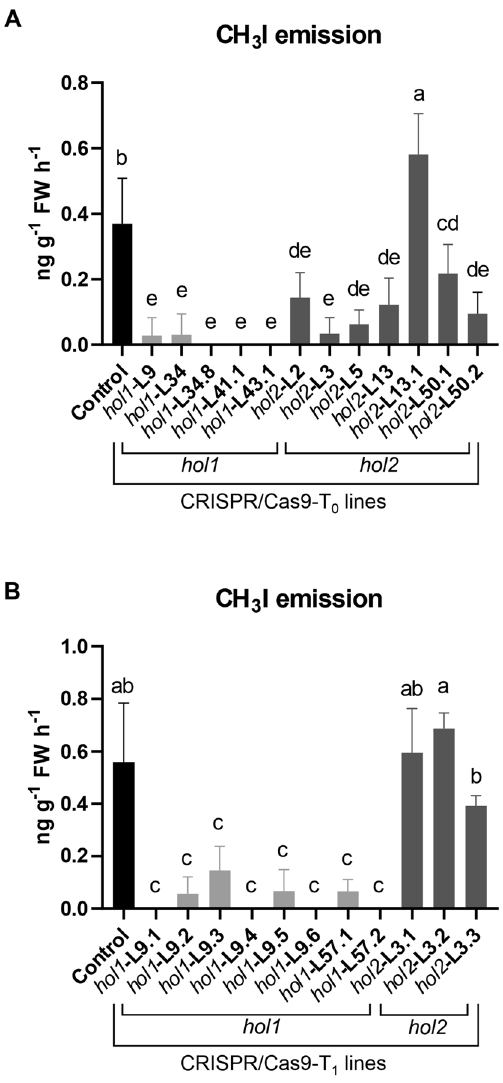
Figure 2. Methyl iodide emissions in CRISPR/Cas9 mutated lines. CH 3 I emissions were measured from T 0 ( A ) and T 1 ( B ) plants. Air samples from leaves were analyzed 24 h after incubation with 0.5 mM KI. Data points are the mean ± s.d. of four biological replicates for each line and two technical replicates per each biological sample. Data were subjected to one-way analysis of variance (ANOVA). Values followed by the same letter are not significantly different (Tukey’s HSD post-hoc test, P ≤